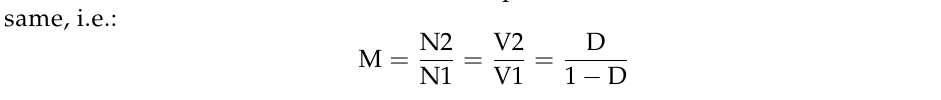
Figure 9. Waveforms during Switch ON and OFF conditions, where {1} and {2} are Vc1 + Vc2 and {3} and {4} are iL1 + iL2.